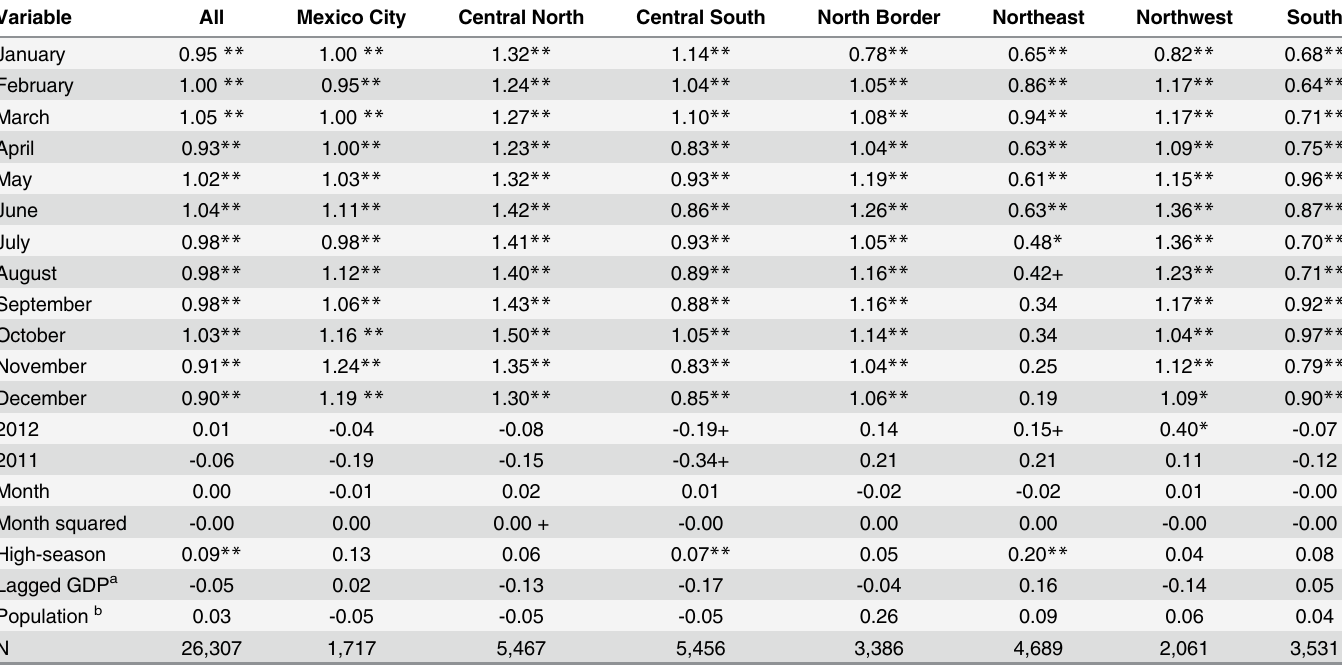
Table 2. Fixed-effects estimating the change in SSB prices (pesos per liter) after the excise tax started by region. Variable